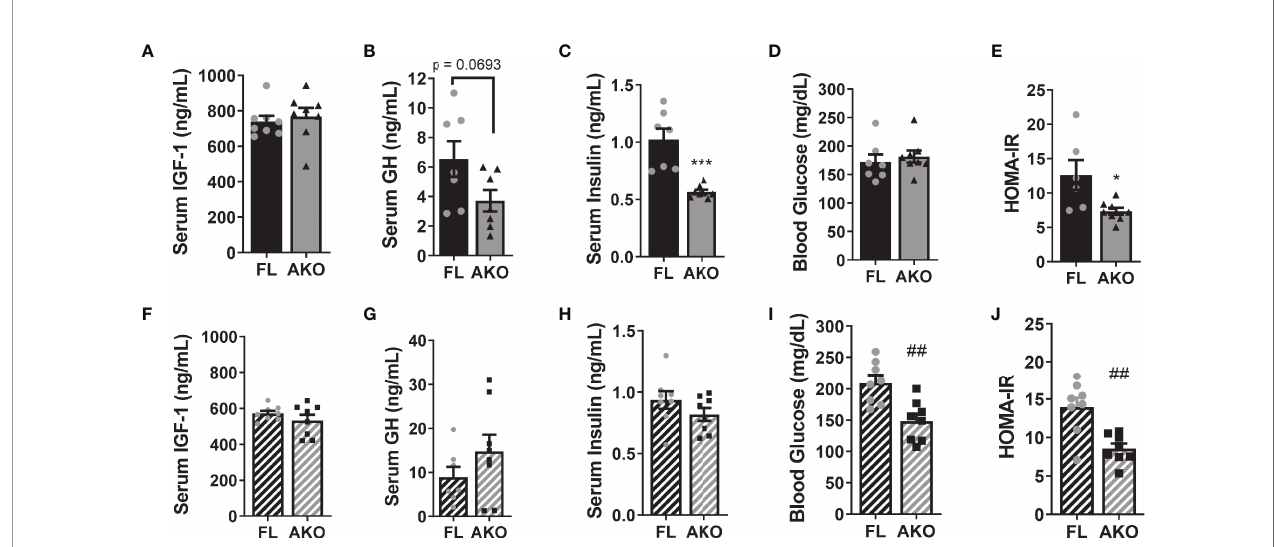
FIGURE 3 | STAT5 AKO mice haveimprovedhomeostasismodel assessment of insulin resistance (HOMA-IR). Female (A – E) and male (F – J) STAT5 AKO (AKO) and fl oxed (FL) littermate control mice were weaned onto regular chow diet (13% kcal from fat) and switched to a de fi ned-composition LFD (10% kcalfromfat) at6 weeks of age (WOA), followedby HFD(60% kcalfromfat) at 11 WOA for 4 days prior to euthanasia. Serum insulin-likegrowth factor 1 (IGF-1; A,F ),growth hormone (GH; B, G ),insulin (C, H) , andblood glucose (D,I) levels in3-month-old mice (n = 7 – 8). (E, J) HOMA-IR was calculated from insulinand glucoselevels, respectively in (C,D) or (H, I) . Signi fi cance was determined by t -test and isdenoted as ***p < 0.001, for AKO versusFLcomparisons infemales and ## p < 0.01